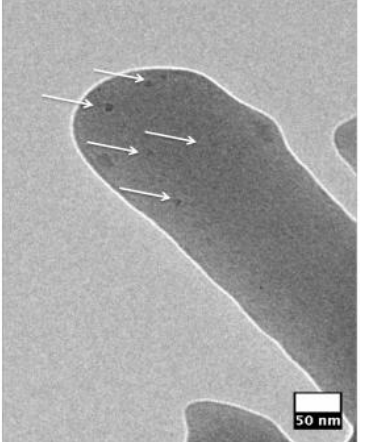
Figure 3. TEM micrograph of a composite fiber. Arrows are pointing to single and small clusters of SNPs in the